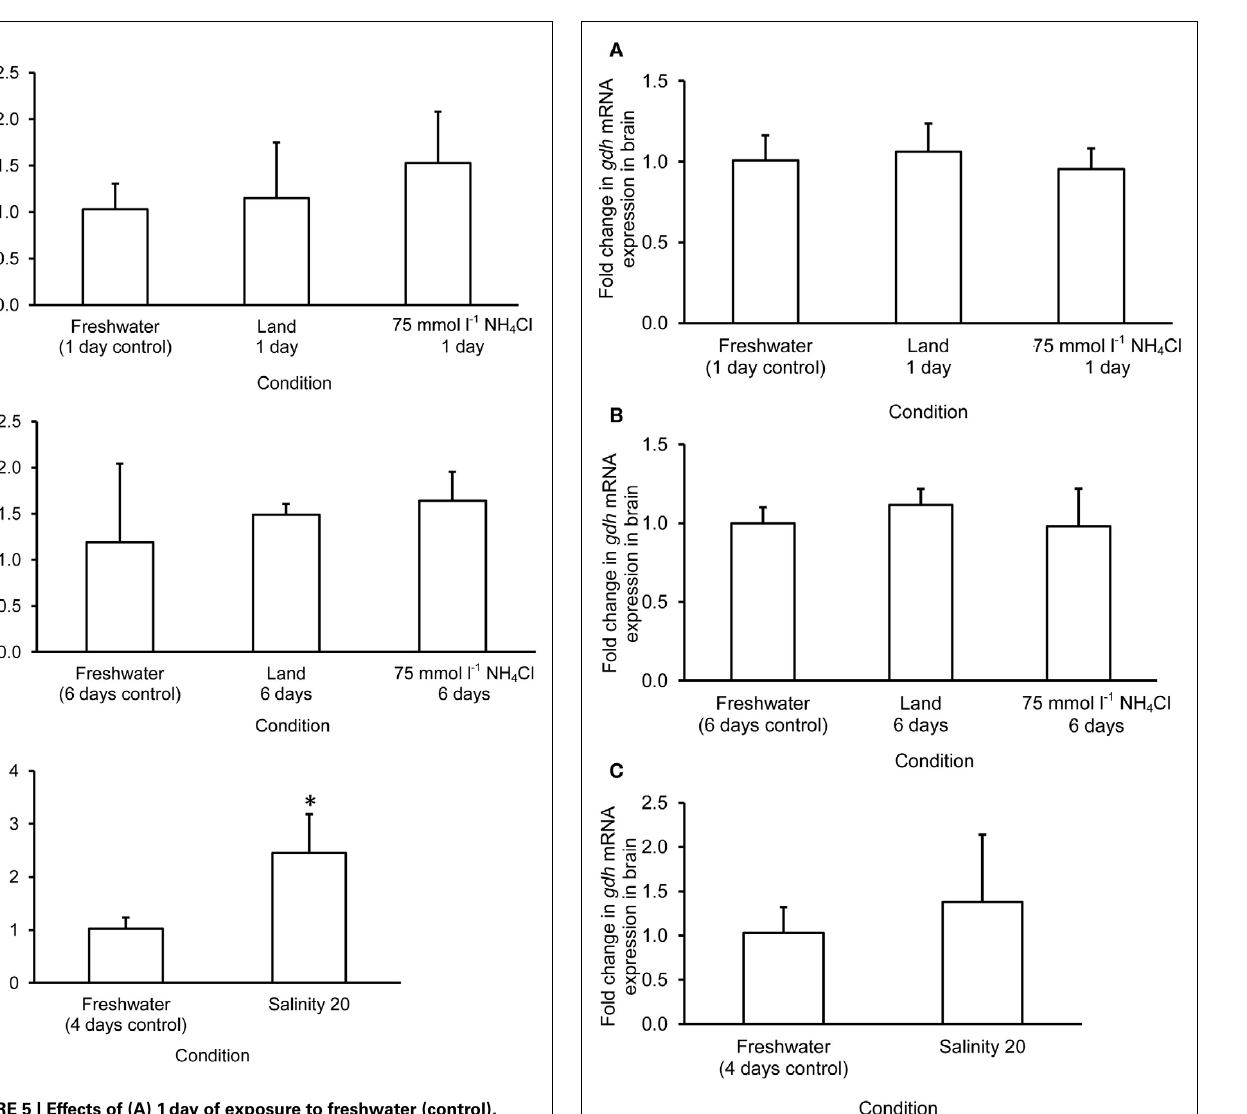
FIGURE 5 | Effects of (A) 1day of exposure to freshwater (control), terrestrial conditions, or 75mmoll − 1 NH 4 Cl, (B) 6days of exposure to freshwater (control), terrestrial conditions (land), or 75mmoll − 1 NH 4 Cl, and (C) 4days of exposure to freshwater (control) or 1day of exposure to salinity 20 after a 3-day progressive increase in salinity from freshwater on the mRNA expression (fold change) of glutamate dehydrogenase 1a ( gdh1a ) in the intestine of Monopterus albus . Results represent mean + SD ( N = 4). Statistical analysis was applied after log 2 transformation of the individual fold change values. ∗ Significantly different from corresponding control, p < 0.05.